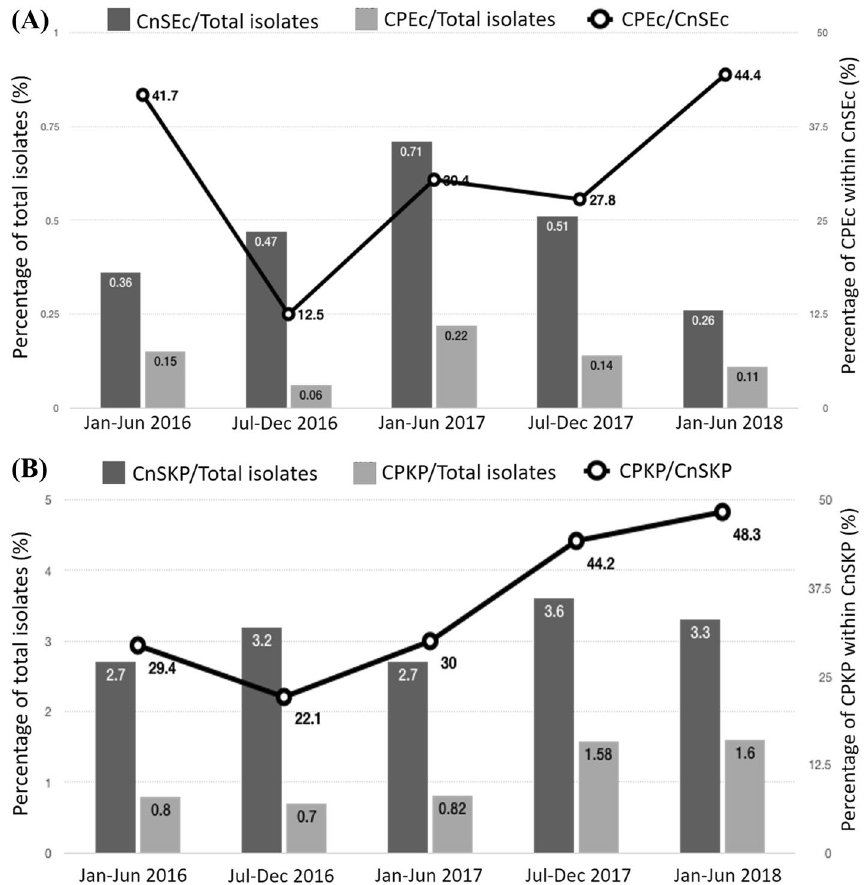
Figure 1. Trend in proportions of ( A ) carbapenem-non-susceptible and carbapenemase-producing E. coli (CnSEc and CPEc), and ( B ) carbapenem-non-susceptible and carbapenemase-producing K. pneumoniae (CnSKP and CPKP) from January 2016 to June 2018.